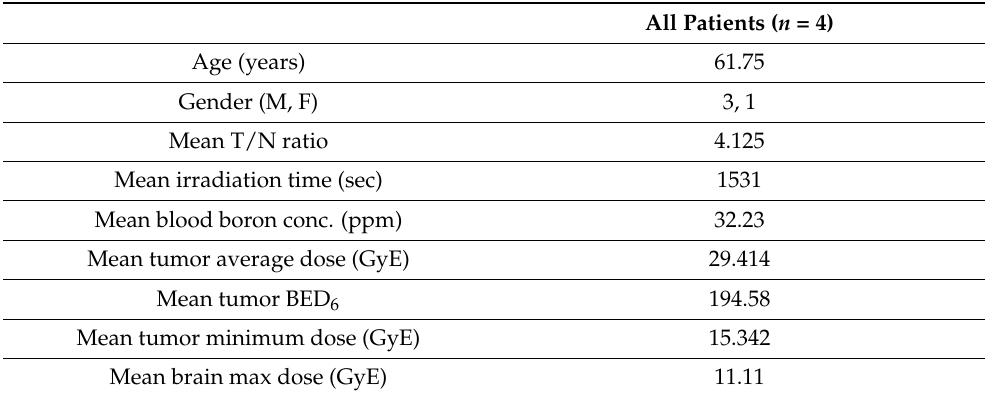
Table 2. General patient characteristics. M: male; F: female; Conc.: concentration; GyE: Gray equivalent; BED 6 : biological effective dose with α / β =